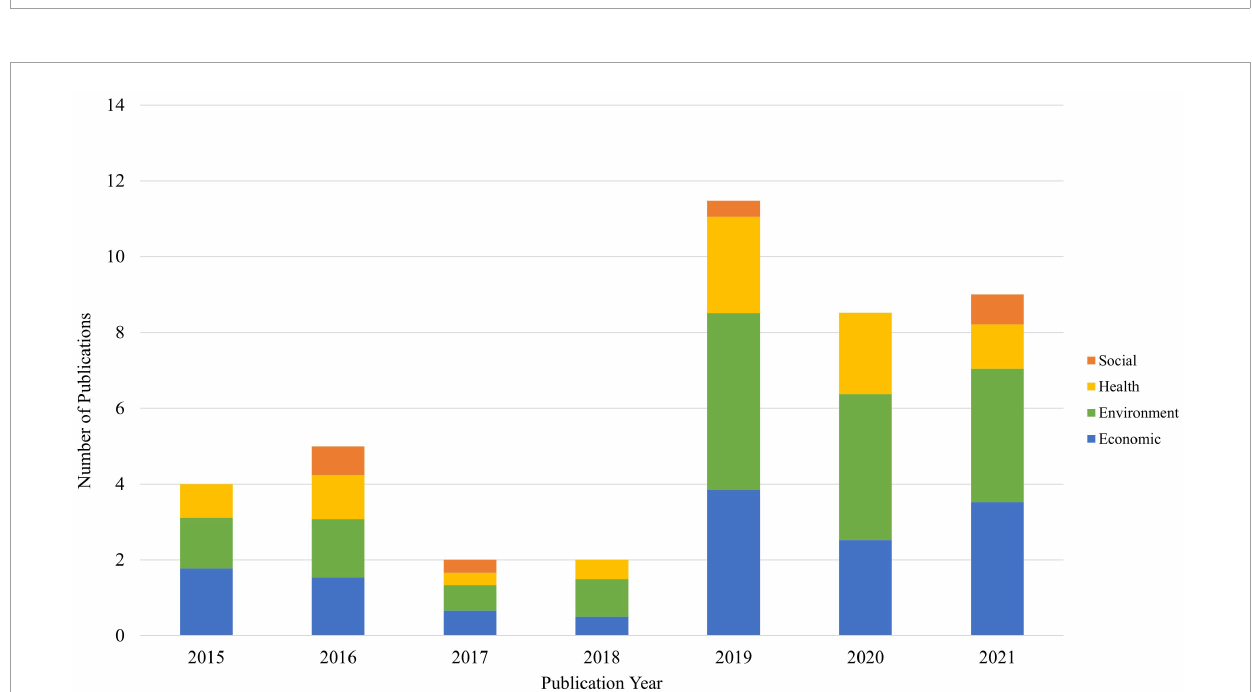
FIGURE2 Frequency count of included pillars, by publication